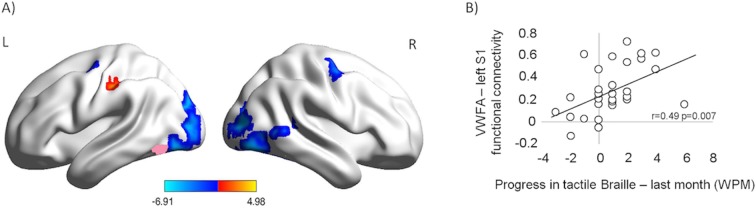
Following the tactile Braille course, the VWFA increased its resting-state connectivity with the somatosensory cortex while decreasing its coupling with other visual areas and the motor cortex.The connectivity between the VWFA and the somatosensory cortex was behaviorally relevant for tactile Braille reading. (A) Functional connectivity of the VWFA after the tactile Braille course relative to the before-course scan. Red represents increased correlation, and blue represents decreased correlation. The VWFA seed is marked in pink. Thresholds: p = 0.001 voxel-wise, p = 0.05 cluster-wise. (B) Correlation between after-course VWFA – left S1 functional connectivity and progress in tactile Braille reading speed in the last month of the course.